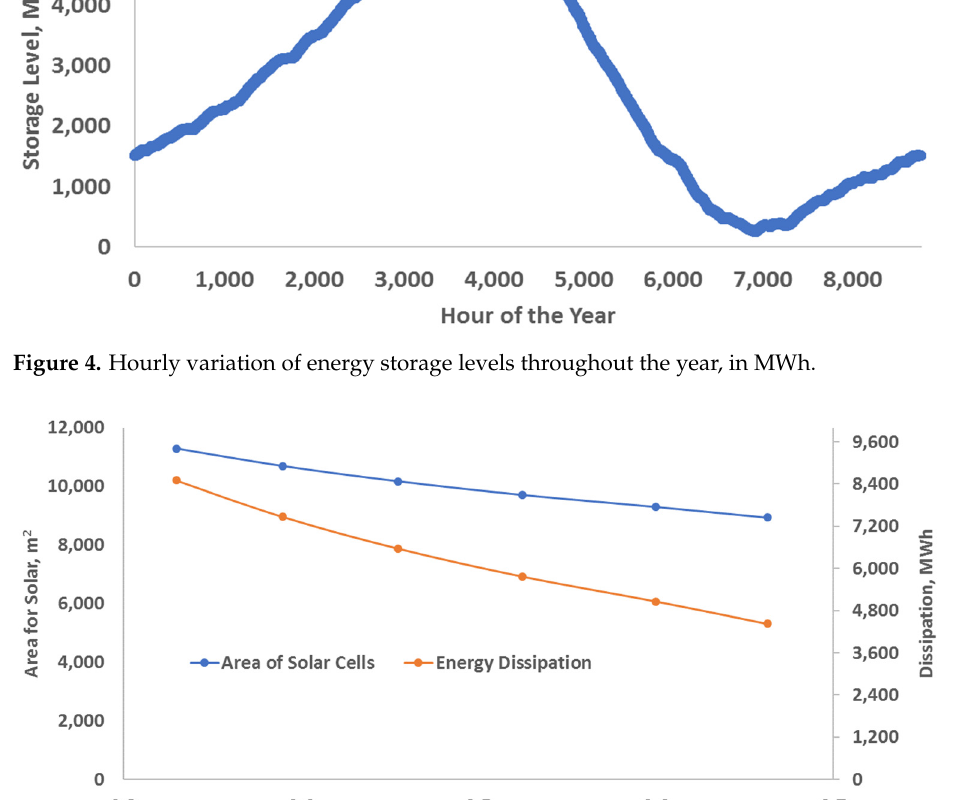
Figure 4. Hourly variation of energy storage levels throughout the year, in MWh.